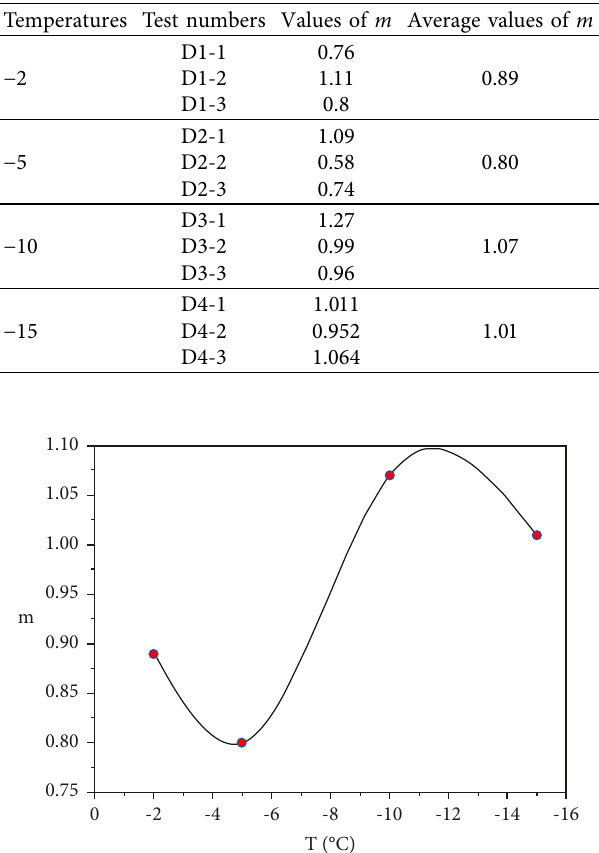
Figure 10: The relationship between temperature and parameter m .